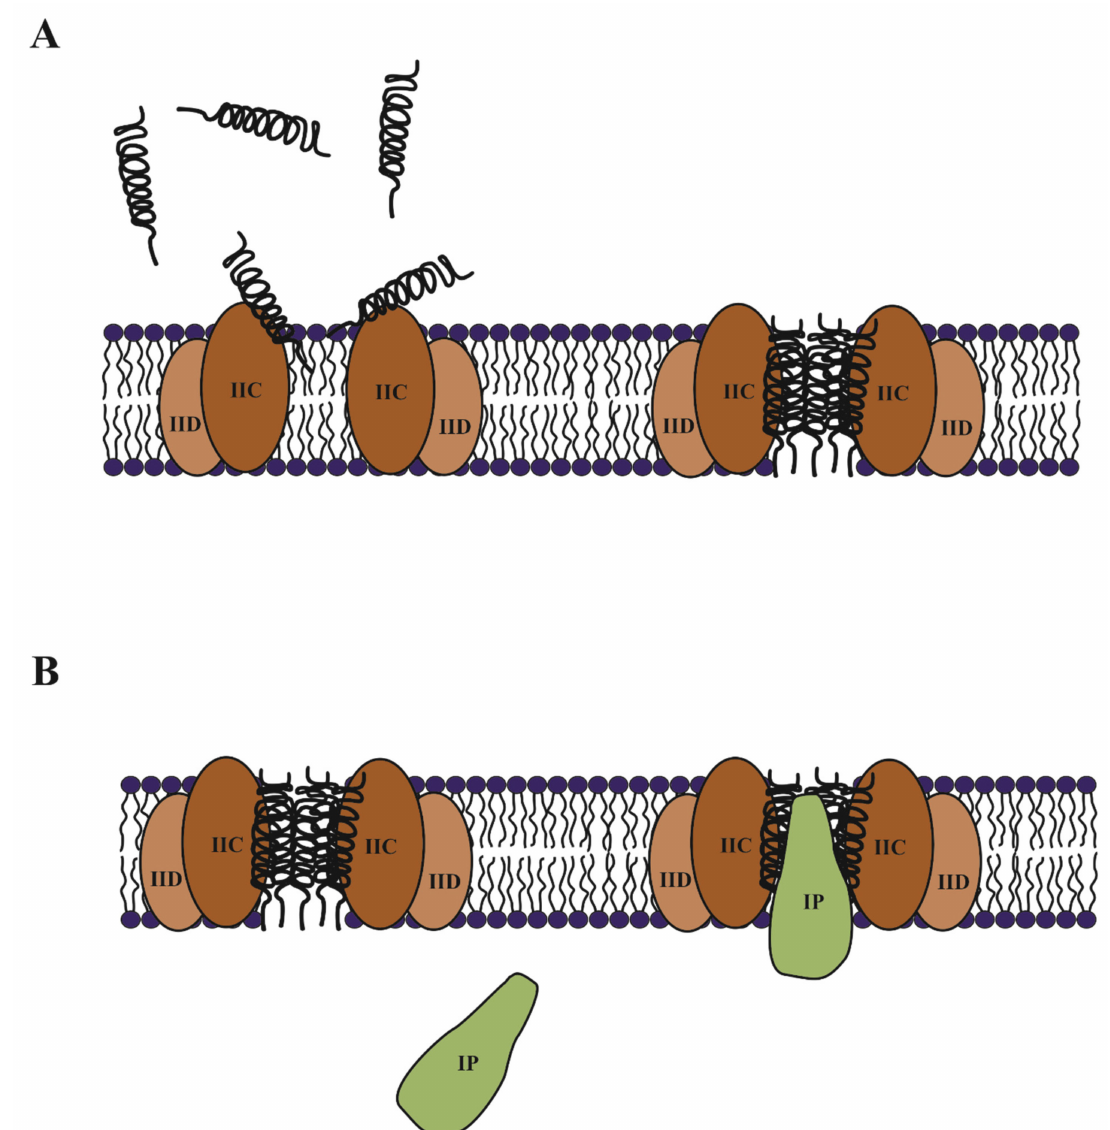
Figure 5. Model of the mechanism of action and immunity for the class IIa bacteriocin, based on the suggestions from enterocin CRL35 [125]. ( A ) The bacteriocin reaches the membrane via interaction with EIIC protein of maltose PTS transporter (EIIC and EIID components). Then, the peptides organize themselves to form the pore. ( B ) The immunity protein (IP) is a soluble cytosolic protein, which interacts with the complex bacteriocin-receptor plugging the formed pore, avoiding cell